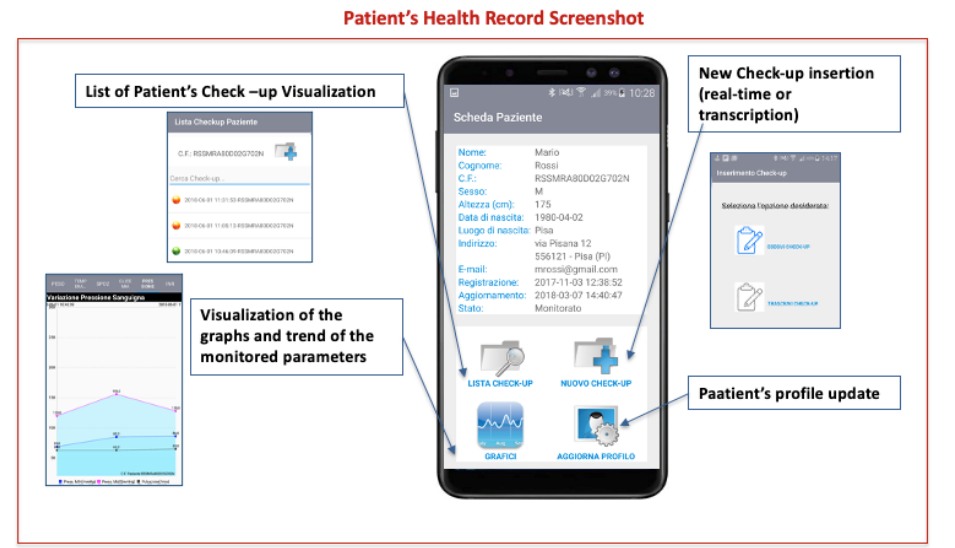
Figure 5. App GUI: Example of screenshots- Patient Health